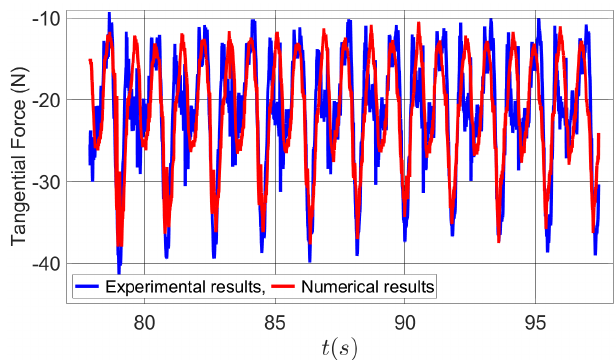
Fig. 3. Comparison of the experimental and numerical values of the tangential